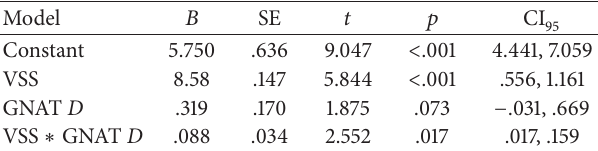
Table 1: Moderated regression analysis for illness attitudes (GNAT D ) moderating vegetative symptom severity (VSS) predicting psy- chological symptom severity (PSS).